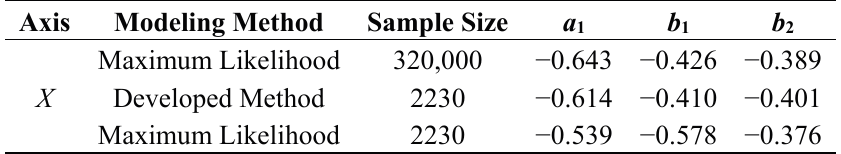
Table 1. Modeling results comparisons between different methods ( x -axis).